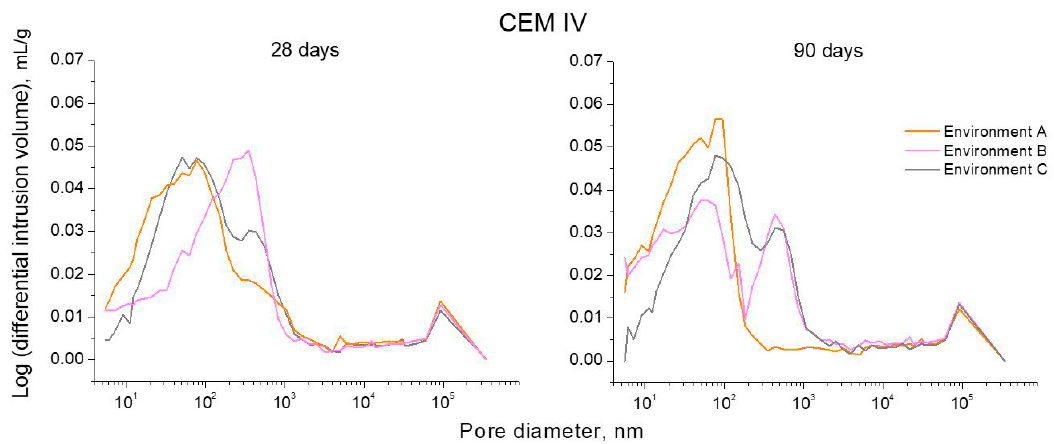
Figure 11. Curves logarithm of differential intrusion volume versus pore size obtained at 28 and 90 hardening days for CEM IV mortars exposed to the three studied environments.